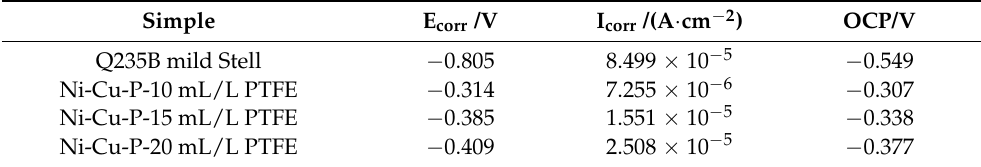
Table 4. Electrochemical parameters of different samples in 3.5 wt% NaCl